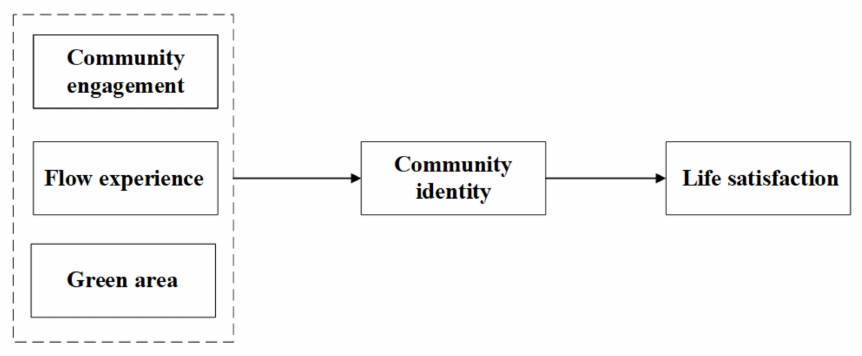
Figure 3. The mediation model: community identity as a mediator. Hypothesis 3 (H3c) : Community identity mediates the path from green area to life satisfaction (innovative